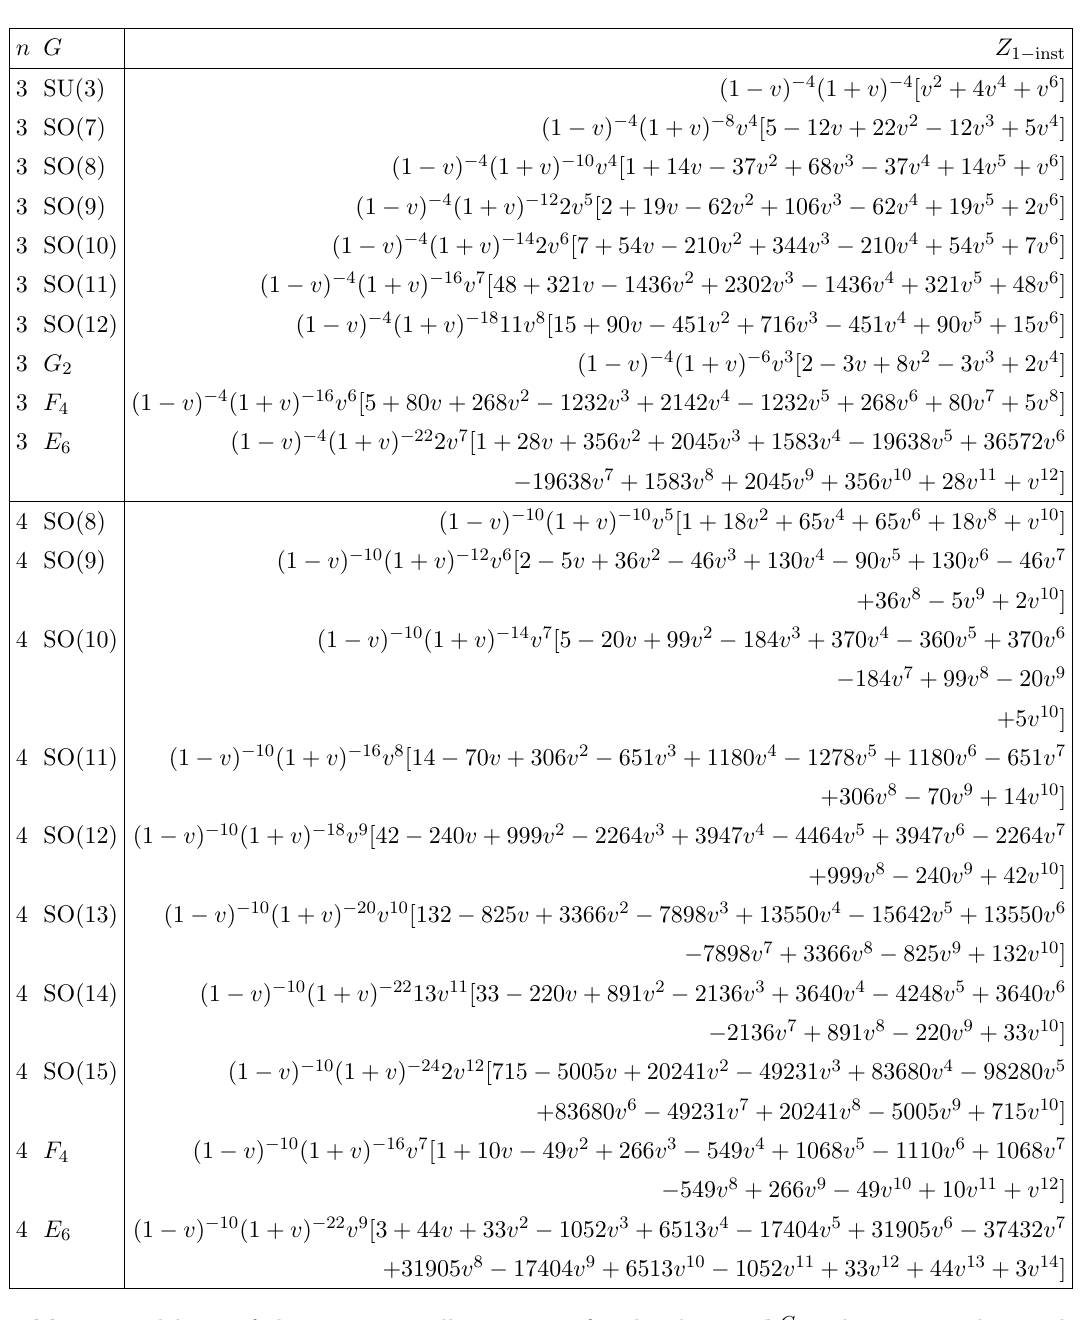
Table 91. 5d limit of the one-string elliptic genus for the theories h G chemical potentials m F ; m G turned